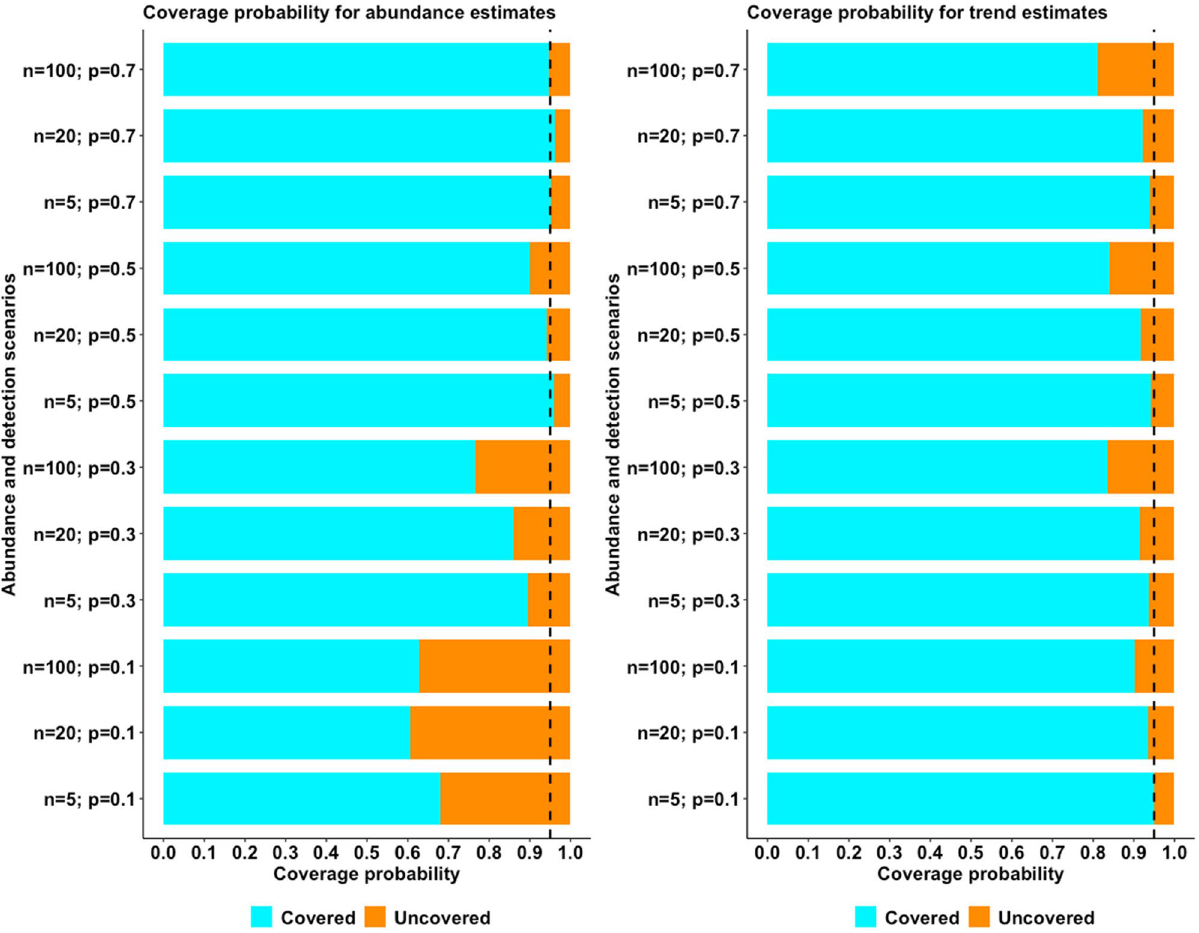
Figure 4. Bar charts representing the proportion of models in which real parameters are covered by the 95% confidence interval. The vertical dashed line represents a 0.95 coverage